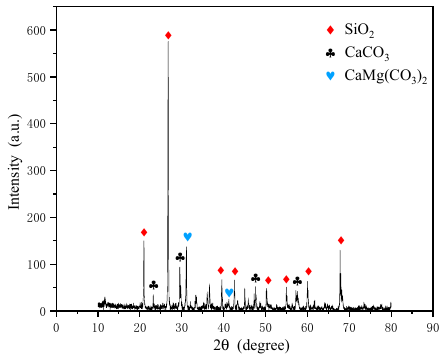
Figure 2. X-ray diffraction.